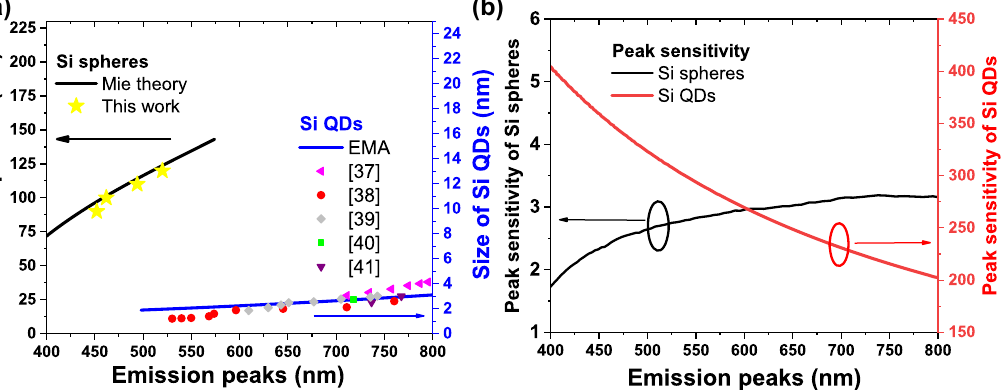
Figure 6: (a) Emission peaks of Si spheres (this study) of various sizes compared with those reported previously for Si QDs [37–41]. (b) Peak sensitivities of Si QDs and Si spheres, calculated using EMA and Mie theory,